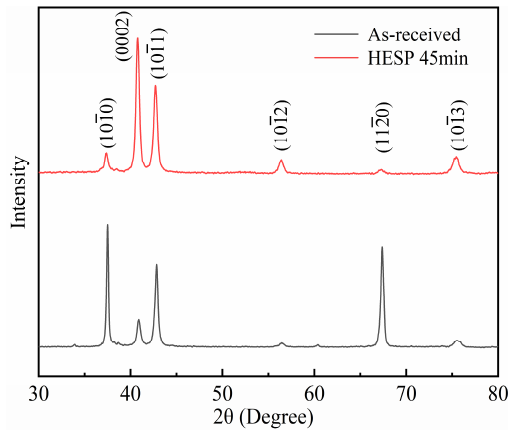
Figure 4. XRD patterns of as-received and HESPed.